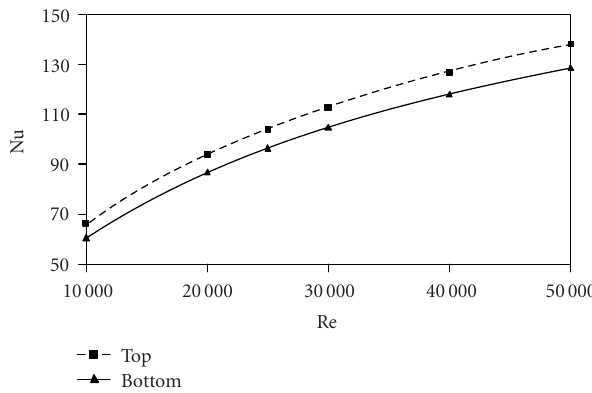
Figure 14: Nondimensional temperature distribution at di ff erent sections of the cooling channel for Re = 50000 and ˙ m r = 1 / 2.